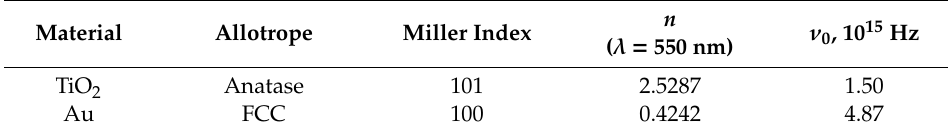
Table 1. Characteristics of the two nanomaterials considered in this paper, detailing the parameters required for the atomistic simulations and the optical characteristics required for the calculation of Hamaker